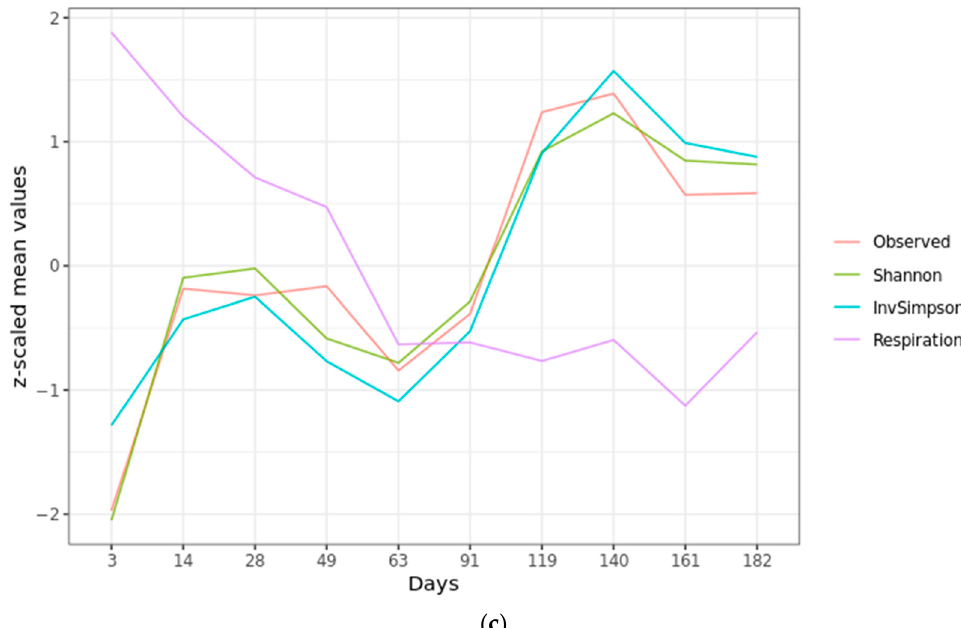
Figure 2. Alpha diversity indices (observed, Shannon, InvSimpson) for ( a ) prokaryotic, based on 16S rRNA gene amplicon libraries, and ( b ) fungal data, based on ITS2 fragment amplicon libraries, divided on the X -axis into three phases: early, middle, and late. Significant differences were assessed by ANOVA with Tukey HSD test: (*) p -value ≤ 0.05; (**) p -value ≤ 0.01; (***) p -value ≤ 0.001; (****) p -value ≤ 0.0001. ( c ) Alpha-diversity indices of prokaryotic community for each sampling day compared to SR data, expressed in z-scaled values.